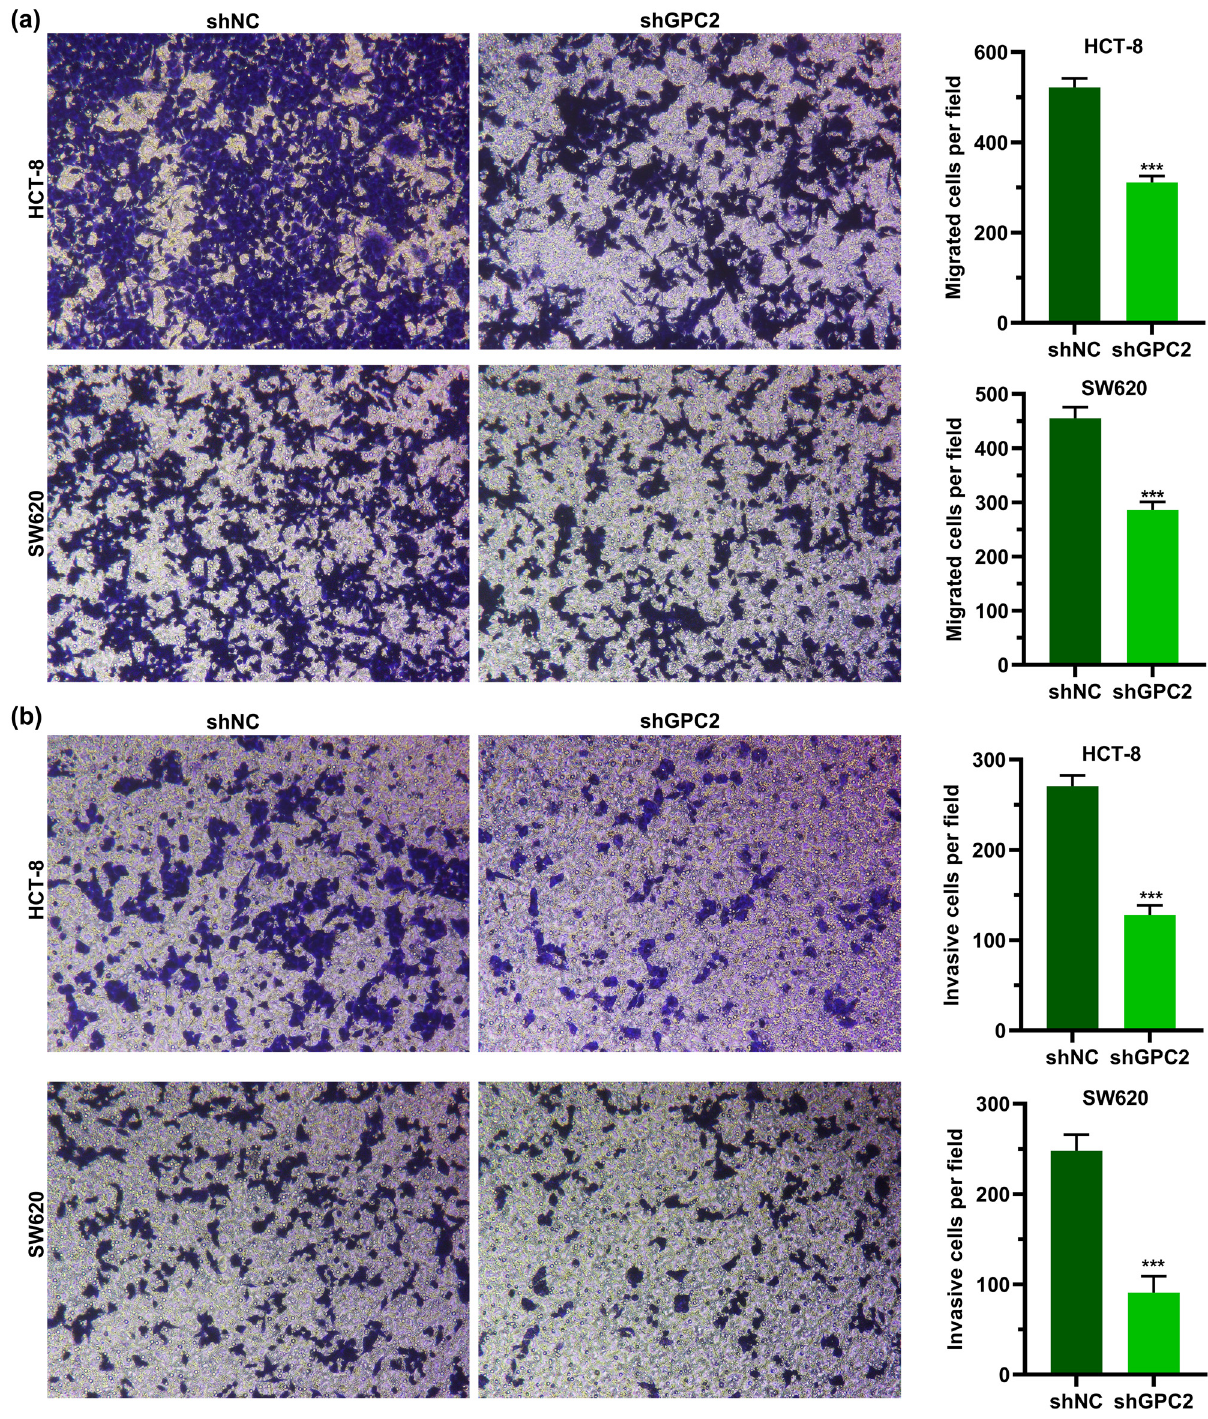
Figure 6: Downregulating GPC2 suppresses migration and invasion HCT - 8 and SW620 cells: ( a and b ) the e ff ect of GPC2 on ( a ) migration or ( b ) invasion of HCT - 8 and SW620 cells was tested using transwell assay ( n = 3 ) . *** P <